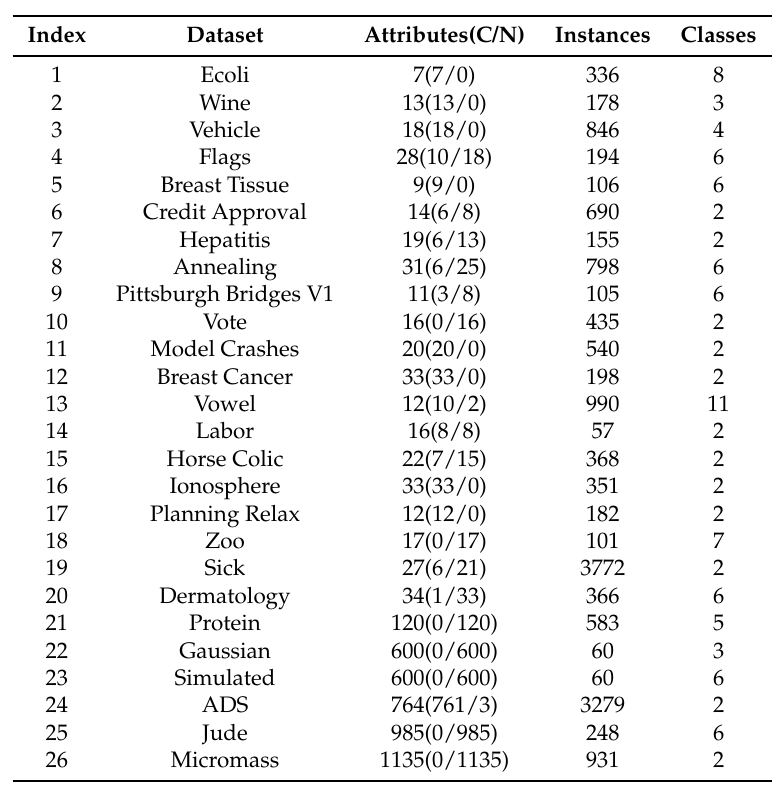
Table 1. Description of the used